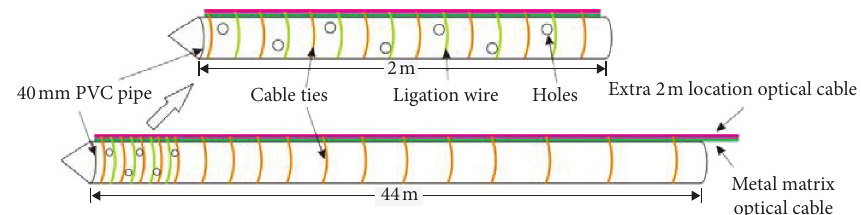
Figure 8: Schematic of distributed optical fibre sensor assembly in the field.